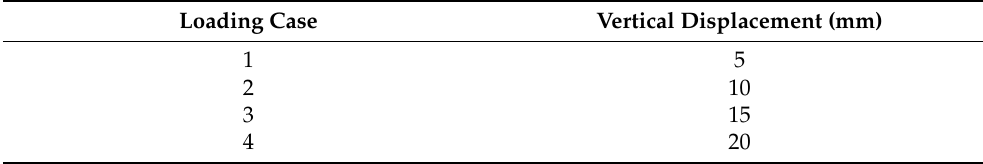
Table 1. Loading condition of experiment 1.